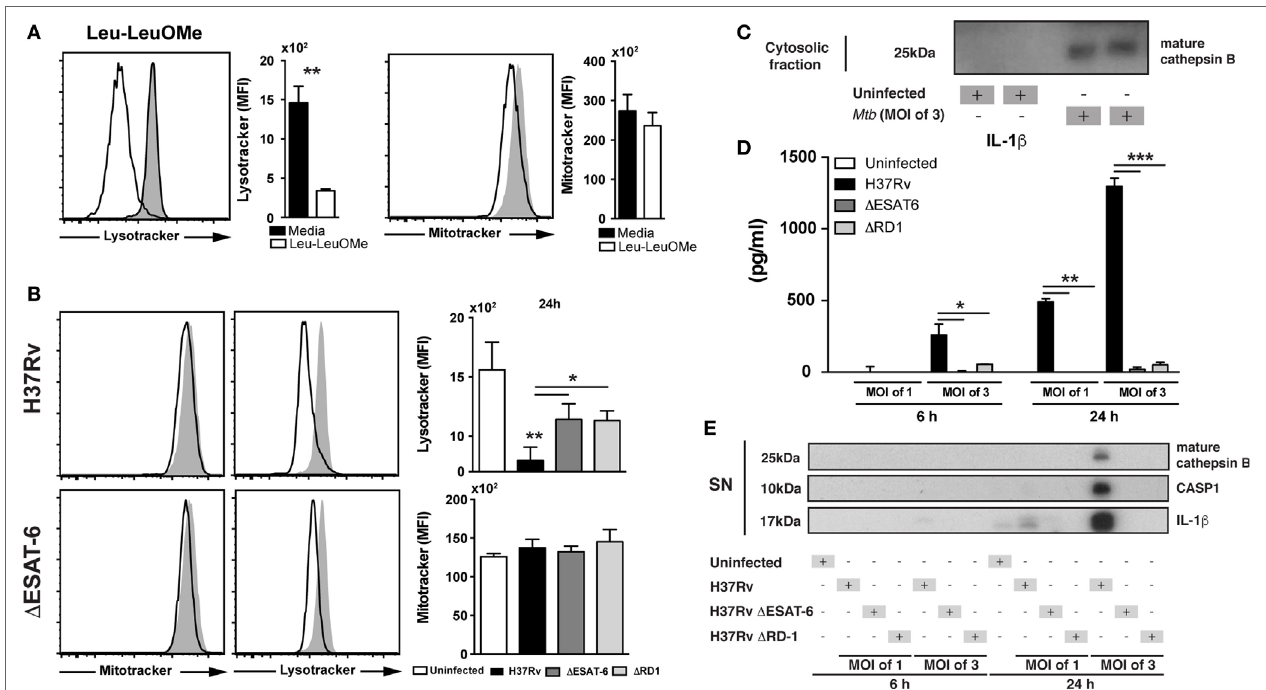
FigUre 2 | Mycobacterium tuberculosis (Mtb) infection induces lysosomal leakage dependent on ESAT6 and leads to release of mature cathepsin B (CTSB) and IL-1 β production. Cells were stained with lysotracker and mitotracker to verify lysosomal leakage or outer mitochondrial membrane potential disturbance at 24 h p.i. with Mtb H37Rv strain (MOI of 3), respectively. (a) Cells were stimulated with Leu-o-Leu as a positive control of lysosomal leakage. (B) Bone marrow-derived macrophages (BMDMs) were infected with H37Rv, Δ ESAT6 H37Rv, or Δ RD1 H37Rv Mtb strains at MOI of 3 as described in Section “Materials and Methods.” Mtb H37Rv induced lysosomal leakage dependent of ESAT6. (c) Cytosolic fraction from BMDMs infected with Mtb H37Rv, showing the presence of mature CTSB. (D,e) BMDMs were infected with H37Rv, Δ ESAT6 H37Rv, or Δ RD1 H37Rv strains at MOI of 1 or MOI of 3 as described in Section “Materials and Methods.” (D) IL-1 β production was measured by ELISA and (e) expression of mature IL-1 β , activated caspases-1, and mature CTSB in the supernatant of cells was assessed by western blotting. Differences were analyzed using the Mann–Whitney U test (between two groups) or the Kruskal–Wallis test with Dunn’s multiple comparisons ad hoc test. Significant differences were observed for the indicated experimental conditions (* p < 0.05; ** p < 0.01). Bars and line represent mean and SEM, respectively. Data are representative of three independent experiments using triplicate biological